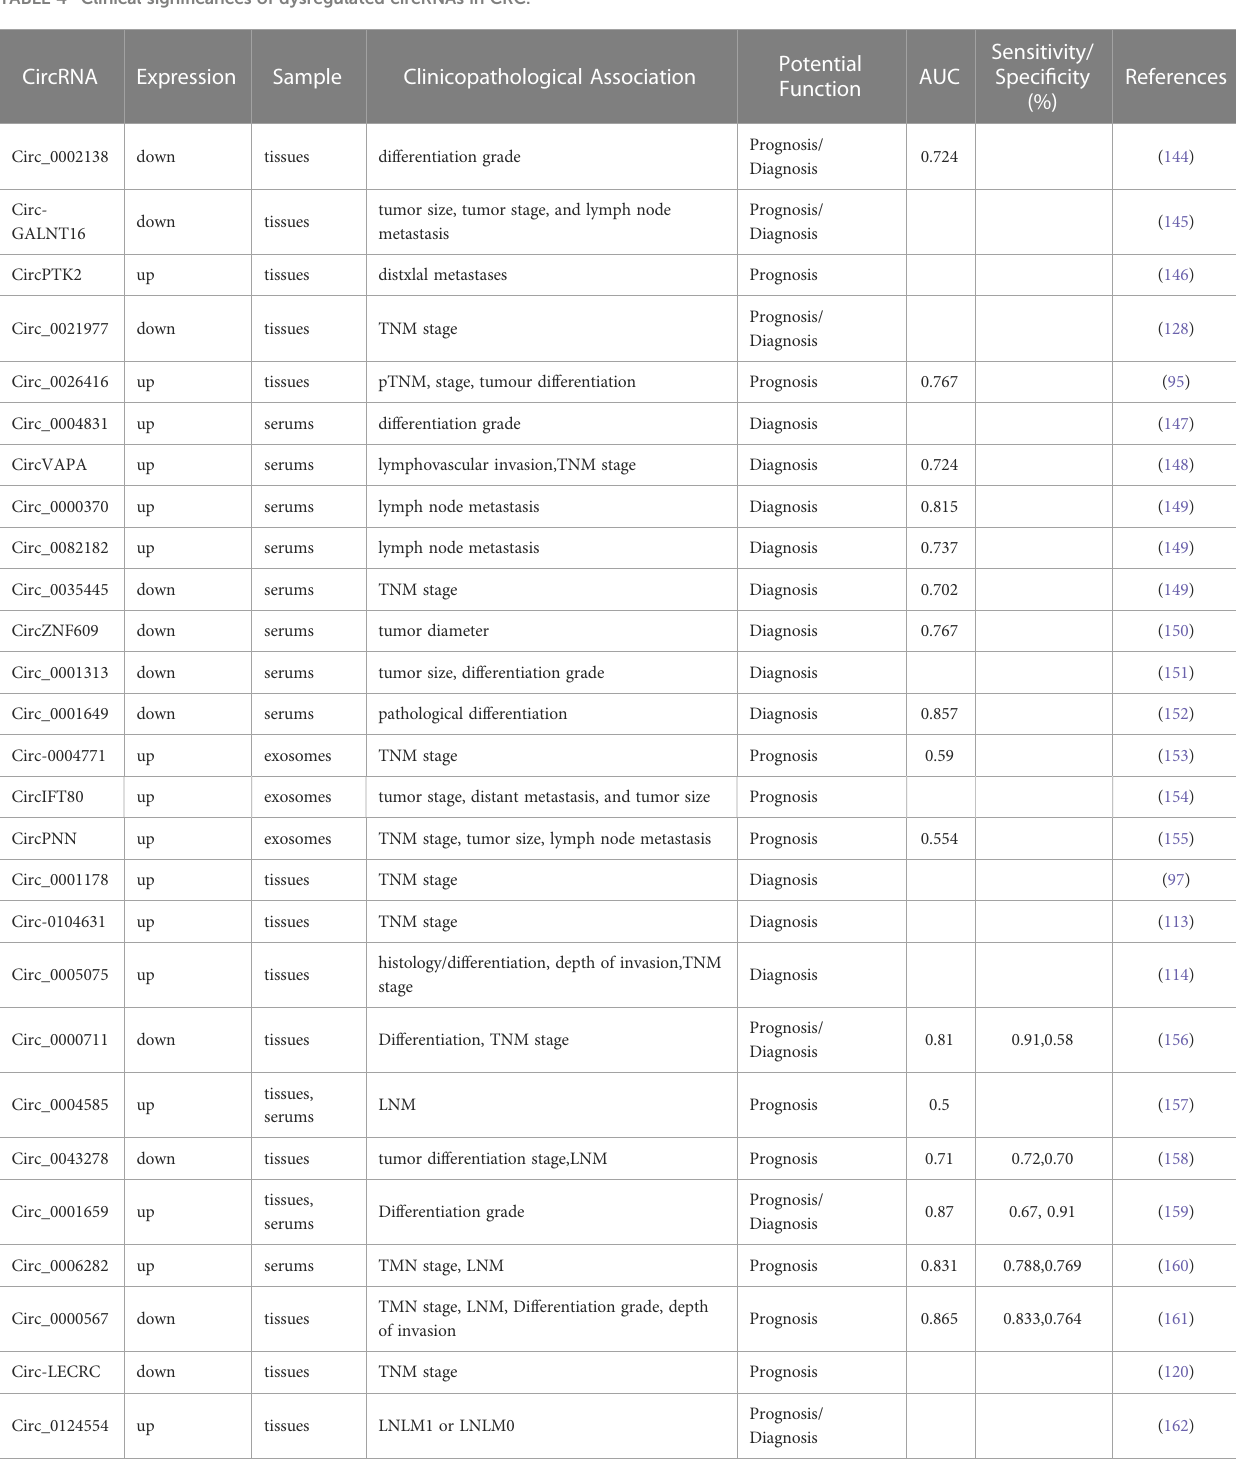
TABLE 4 Clinical signi fi cances of dysregulated circRNAs in CRC.